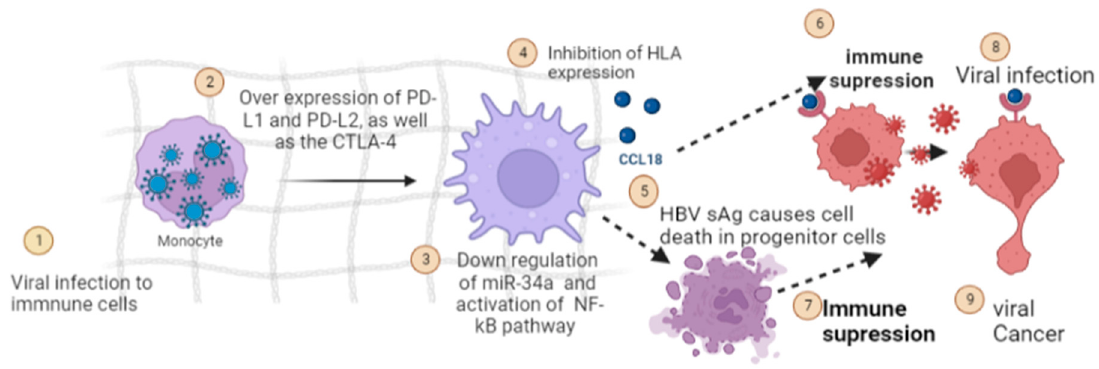
Figure 4. Immunosuppression is caused by oncogenic proteins of viral origin, which cause conditions favorable for the progression of cancer pathways induced by carcinogenic viruses (Image created by biorender.com, accessed on 2 November 2022).